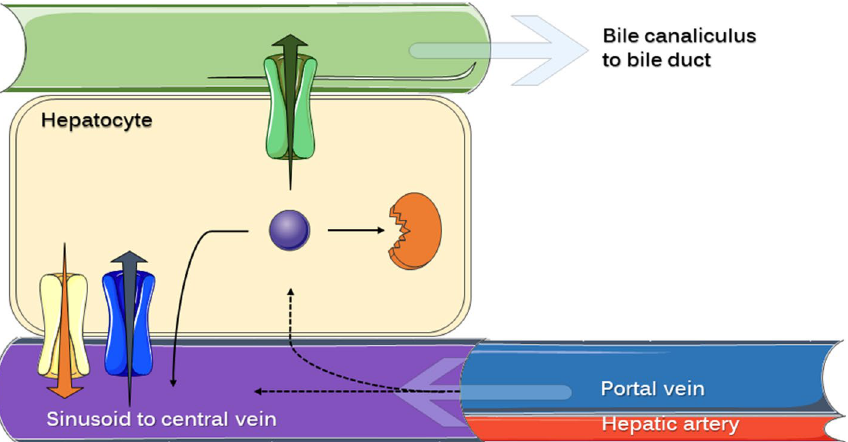
Figure 1. Schematic representation of the different routes that a drug can follow during its passage through the liver. The hepatocyte environment is shown, emphasizing the presence of drug transporters (influx and efflux) at the different membranes and the spatial relation with blood and bile circulation. Either arriving from the portal vein or the hepatic artery, drug circulating in liver sinusoids can be active or passively transferred into the hepatocyte or keep circulating towards the central vein (systemic circulation). Black dashed arrows represent these transferences. Intracellular drug (violet sphere) will be suffer one of these processes: hepatobiliary secretion (active efflux represented by green transporters), enzyme-mediated biotransformation (orange structure representing intracellular metabolic enzyme) or transference back into sinusoidal blood (active or passive). Yellow structures with orange arrow represent efflux transporters at the basolateral membrane (such as MRP3 and MRP4), while blue structures with blue arrow represent influx transporters (such as OATP). Bile canaliculus convey in the bile duct delivering the fluid into the gallbladder. This figure was prepared using content from Servier Medical Art, licensed under a Creative Common Attribution 3.0 Generic License. http:// smart .servi